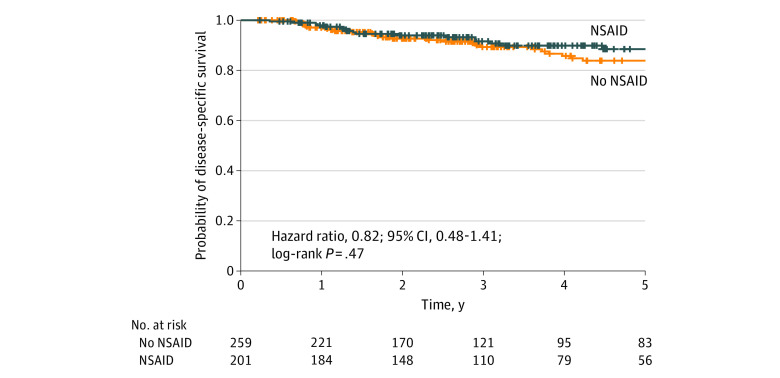
DSS for Patients Taking NSAIDs vs Patients Not Taking NSAIDsNSAID indicates nonsteroidal anti-inflammatory drug.